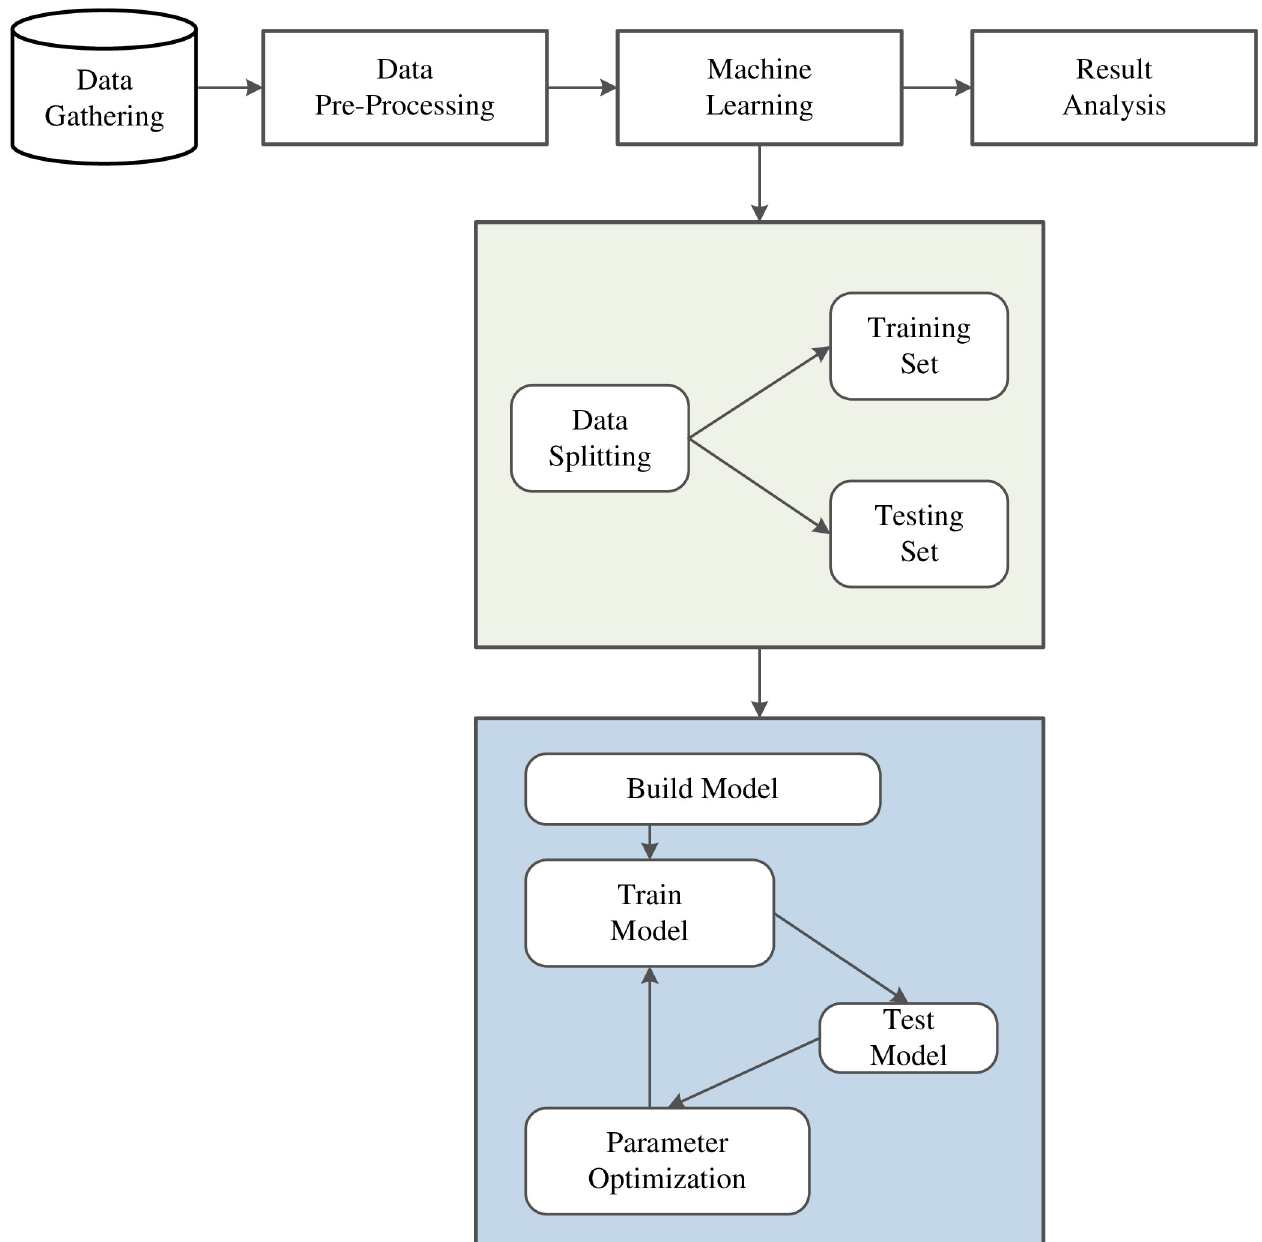
Fig 3. Framework diagram of performance prediction